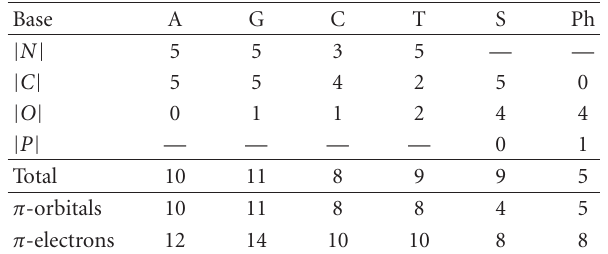
Table 1: The total numbers | N | , | C | , | O | , and | P | of N, C, O, and P atoms and of π -orbitals and π -electrons in the bases of A, G, C, and T, and the sugar(S) and phosphate(Ph) groups, respectively. Here there are 12, 14, 10, and 10 π -electrons for the 10, 11, 8, and 8 π - orbitals in the A, G, C, and T base molecules, respectively, while there are 8 and 8 π -electrons for the 4 and 5 π -orbitals in the sugar and phosphate groups, respectively. Here we note that the carbon atom of CH 3 in the T molecule does not have any π -electron since it forms the sp 3 -hybrid orbitals. This provides 8 π -electrons for the T